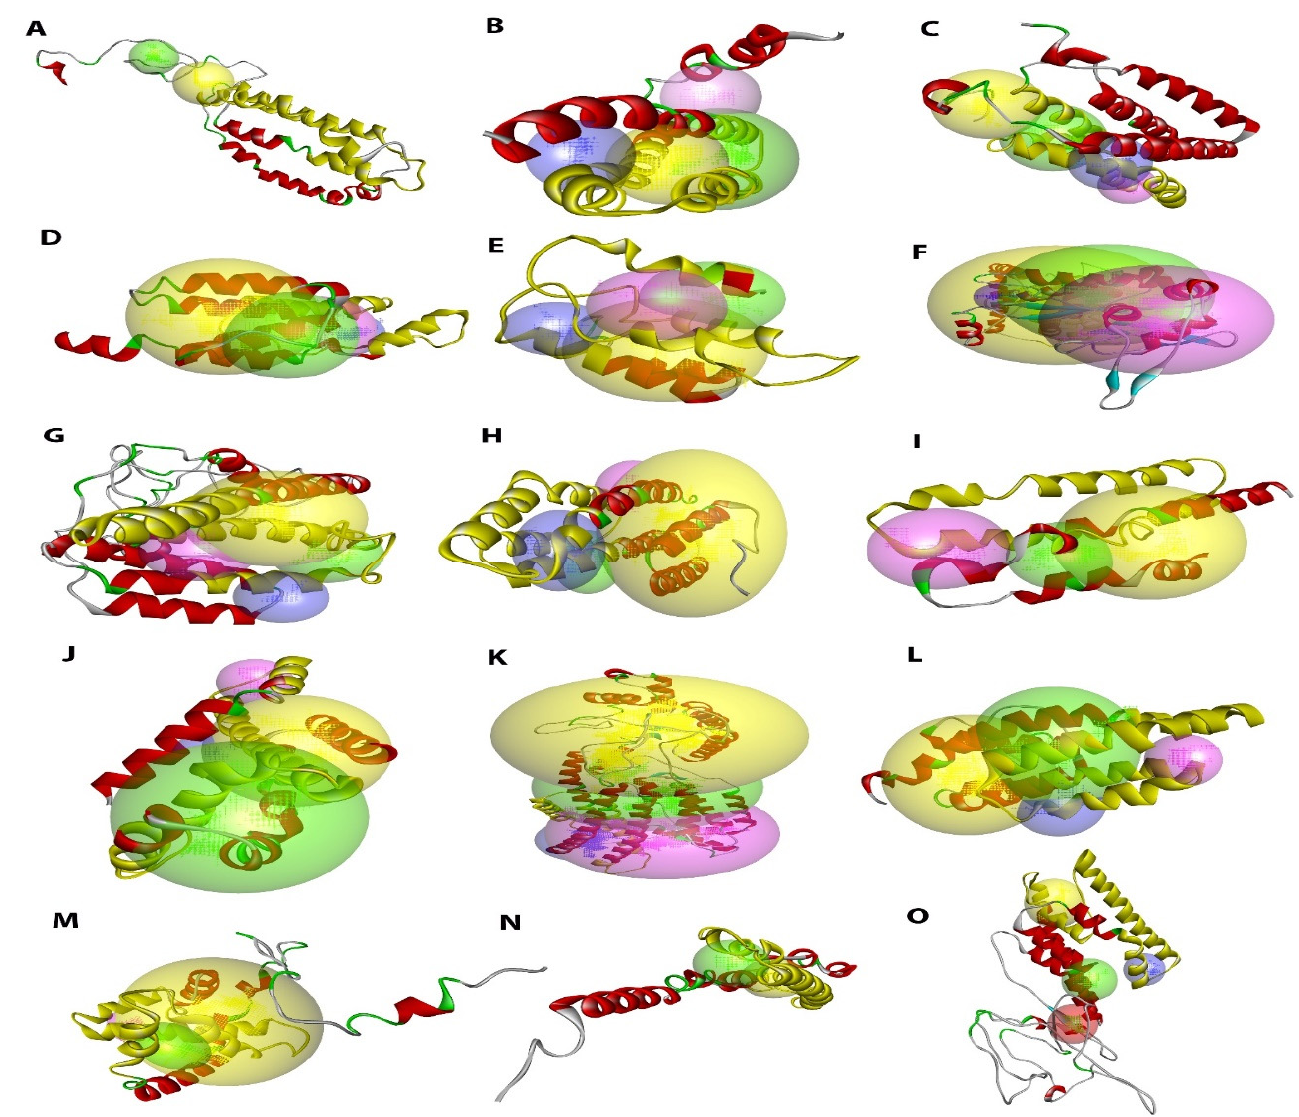
Figure 5. Predicted three-dimensional homology structure of tomato HVA22 proteins. The final 3D structures of SlHVA22 proteins were built by Discovery Studio v.21.1. The secondary structural components: α -helices (red), β -sheets (cyan), coils (green), and loops (gray) as well as the top four putative binding sites: site 1 (yellow sphere), site 2 (green sphere), site 3 (red sphere), and site 4 (blue sphere) are indicated in the predicted 3D models of ( A ) SlHVA22a; ( B ) SlHVA22b; ( C ) SlHVA22c; ( D ) SlHVA22d; ( E ) SlHVA22e; ( F ) SlHVA22f; ( G ) SlHVA22g; ( H ) SlHVA22h; ( I ) SlHVA22i; ( J ) SlHVA22j; ( K ) SlHVA22k; ( L ) SlHVA22l; ( M ) SlHVA22m; ( N ) SlHVA22n; and ( O ) SlHVA22o. The TB2/DP1/HVA22 domain portions in the generated models are underlined in